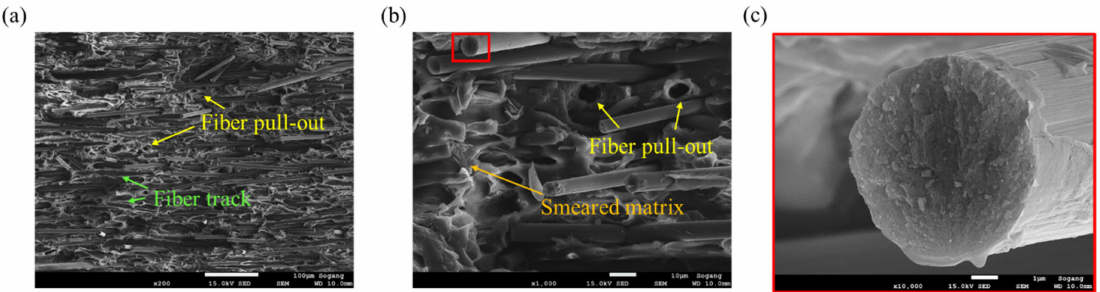
Figure 12. Fracture mechanism observed for θ = 45 ◦ tensile specimen, ( a ) fiber pull-outs and fiber tracks (magnification: × 200, scale: 100 µ m), ( b ) smeared matrix and fiber pull-outs (magnification: × 1000, scale: 10 µ m), ( c ) fracture surface of the fiber (magnification: × 10,000, scale: 1 µ